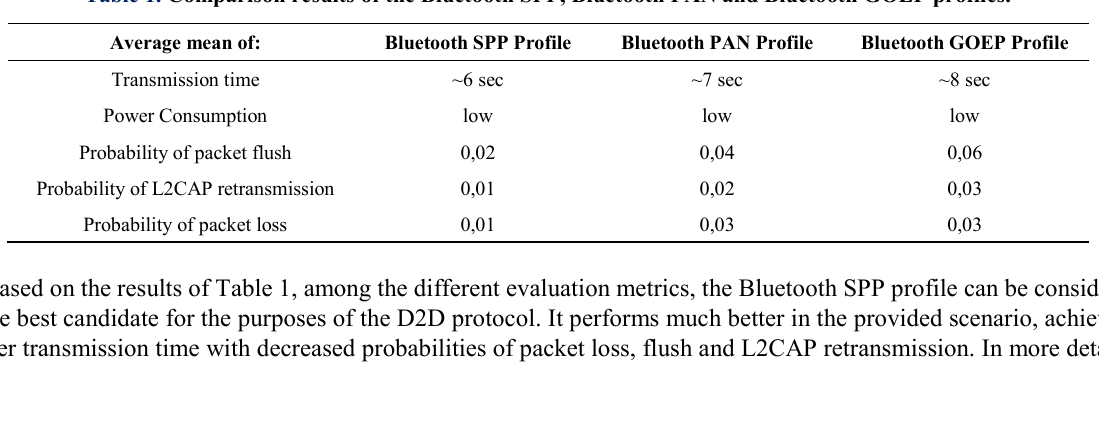
Table 1. Comparison results of the Bluetooth SPP, Bluetooth PAN and Bluetooth GOEP